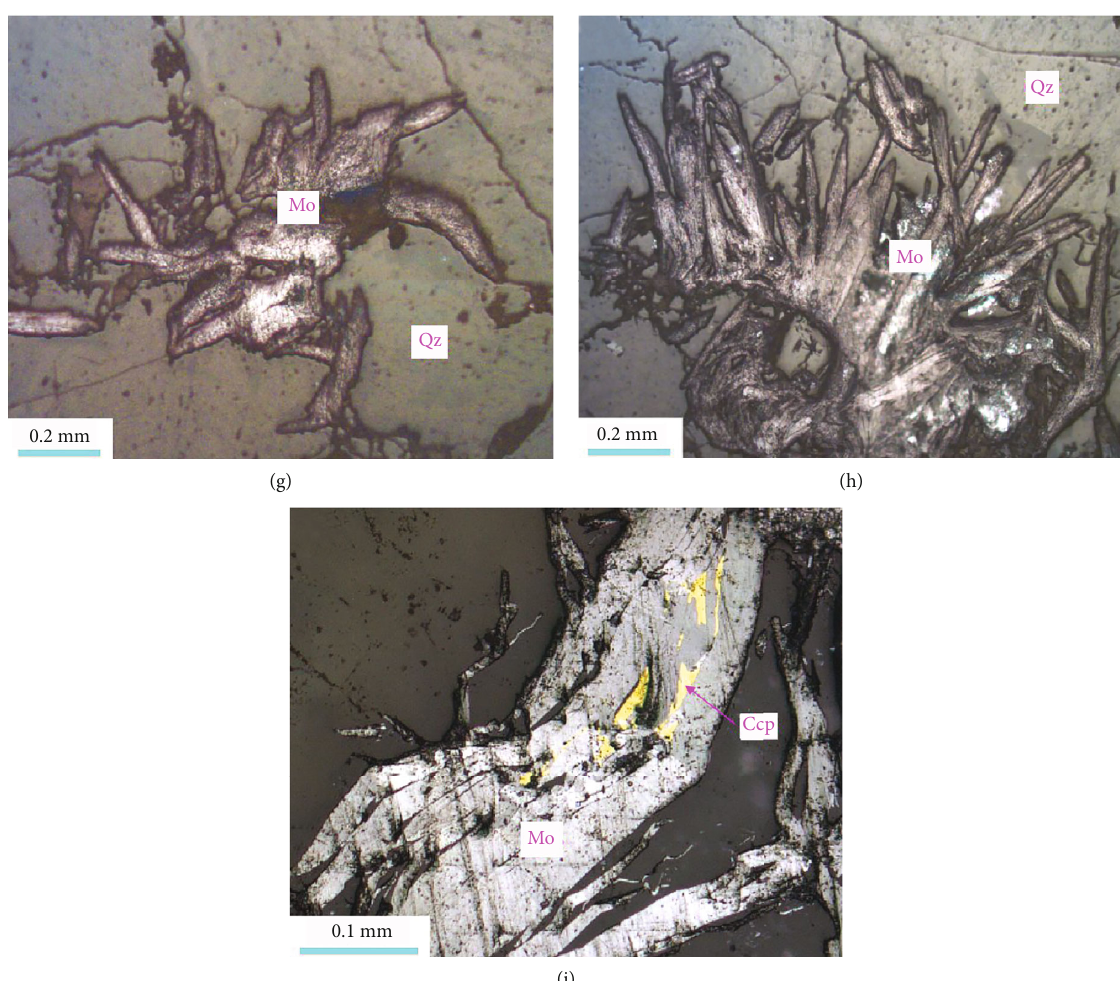
Figure 4: Characteristics of the rocks and ore minerals of the Tieling Cu-Mo deposit. (a) Disseminated molybdenite and pyrite in granite porphyry; (b) porphyritic texture of granite porphyry; (c) porphyritic texture of granite porphyry; (d) molybdenite in quartz vein; (e) molybdenite and pyrite coexisting in quartz vein and epidote fi lls in fi ssures; (f) veinlet molybdenite in granite porphyry; (g) molybdenite in quartz vein; (h) fascicular molybdenite in quartz vein; (i) molybdenite and chalcopyrite coexisting with quartz. Qz: quartz; Kf: K-feldspar; Ep: epidote; Bi: biotite; Mo: molybdenite; Py: pyrite; Ccp: chalcopyrite.